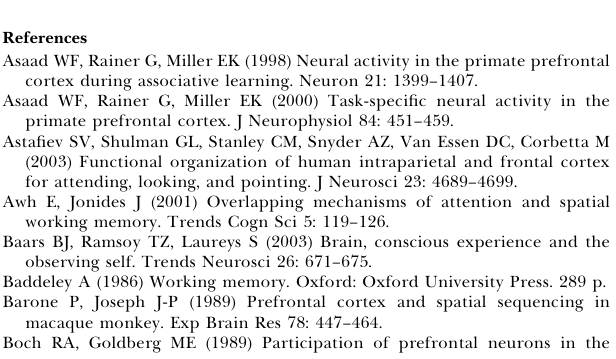
Figure S6. Activity Early Versus Late in the Delay Period Same PFdl neuron as in Figure S1, in the format of Figure S5. The red boxes show the measured period for the cell’s preferred location in both (A) and (B). Figure S7. Neuron-Dropping Curves for the Two Monkeys Combined Format as in Figure 7A–7D. DOI: 10.1371/journal.pbio.0020365.sg007 (46 KB